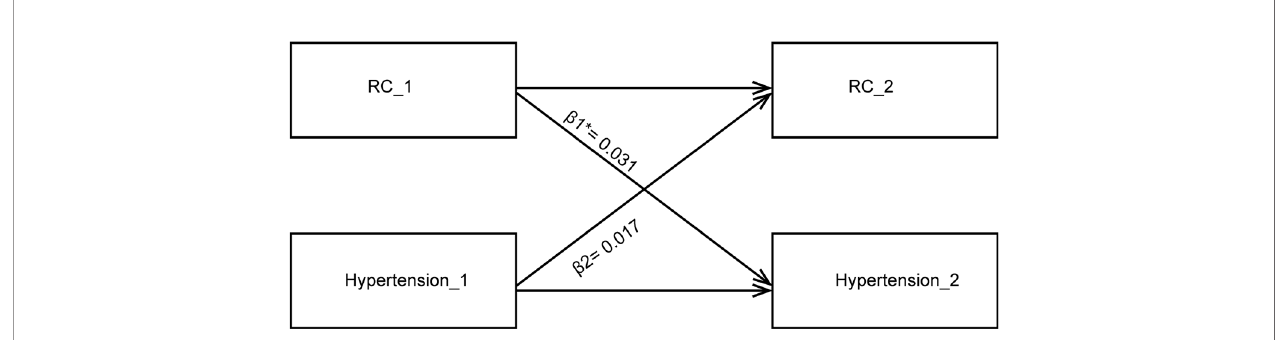
FIGURE 2 | Cross-lagged path analysis for RC level and hypertension. The cross-lagged model is adjusted for age, sex, heart rate, body mass index, fasting blood glucose, alanine aminotransferase, leukocyte count, and serum creatinine. RC, remnant cholesterol; * indicates P <0.001 when comparing b 1 vs. b